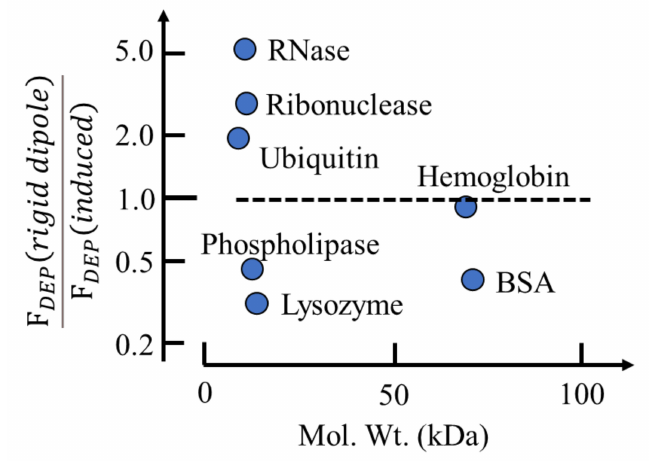
Figure 3. The contribution to the DEP force that a rigid dipole moment makes relative to that of the induced moment is shown for various proteins, as calculated using Equation (15). Values of the hydrodynamic radii were derived using an empirical relationship between protein size and molecular weight (Malvern Panalytical ® —Zetasizer Nano ZS) and permanent dipole moment values were derived from the literature [4,24].